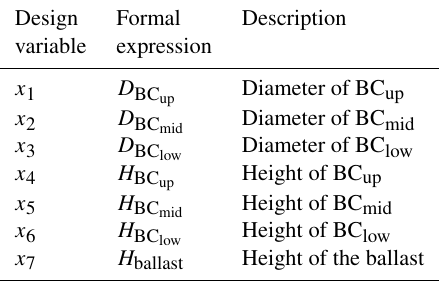
Table 2. Definition of the seven design